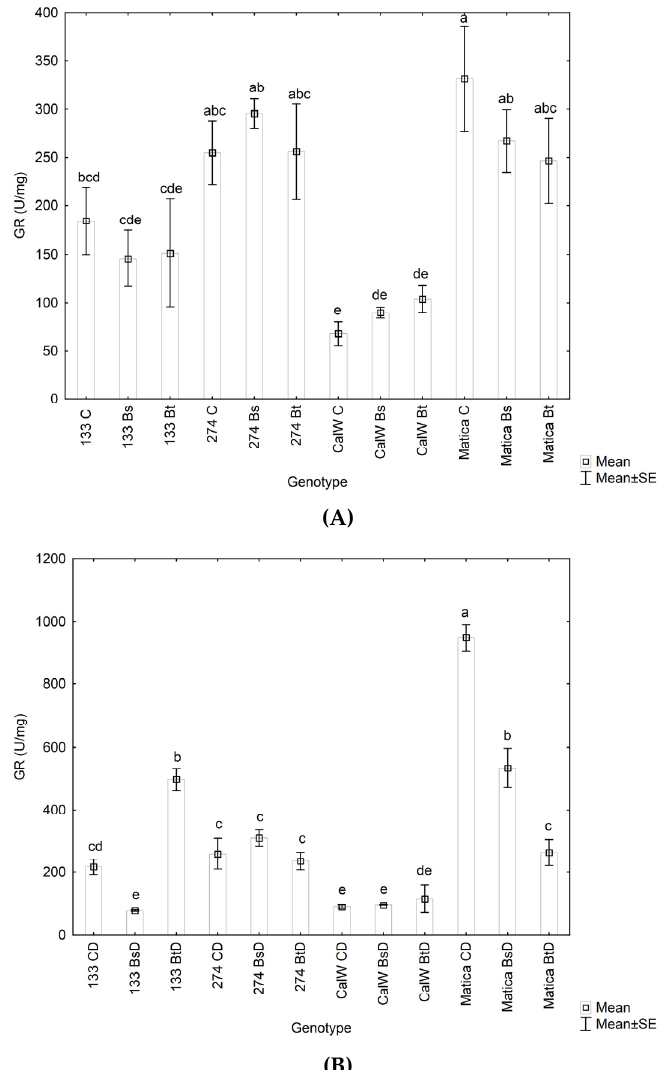
Figure 2. The activity of glutathione reductase (GR) in leaves of four pepper genotypes in ( A ) control (C) and ( B ) drought (D) conditions treated with two bacterial strains, B. safensis SS-2.7—Bs and B. thuringiensis SS-29.2—Bt. Different letters show significant differences between genotypes ( p < 0.05) according to Duncan’s test. Table 2. Activity of ascorbate peroxidase (APX) and total soluble peroxidase (POD) in leaves of four pepper genotypes in well-watered (C) and drought (D) conditions with and without treatment with two bacterial strains ( B. safensis SS-2.7—Bs) and ( B. thuringiensis SS-29.2—Bt).